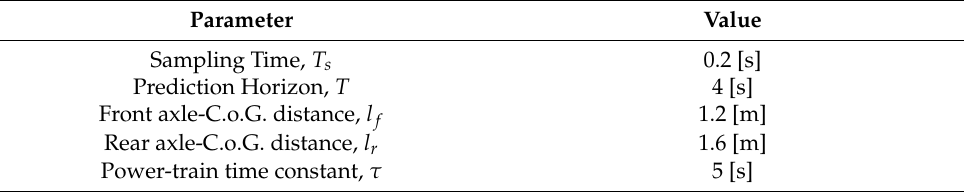
Table 2. Vehicle model and OCP